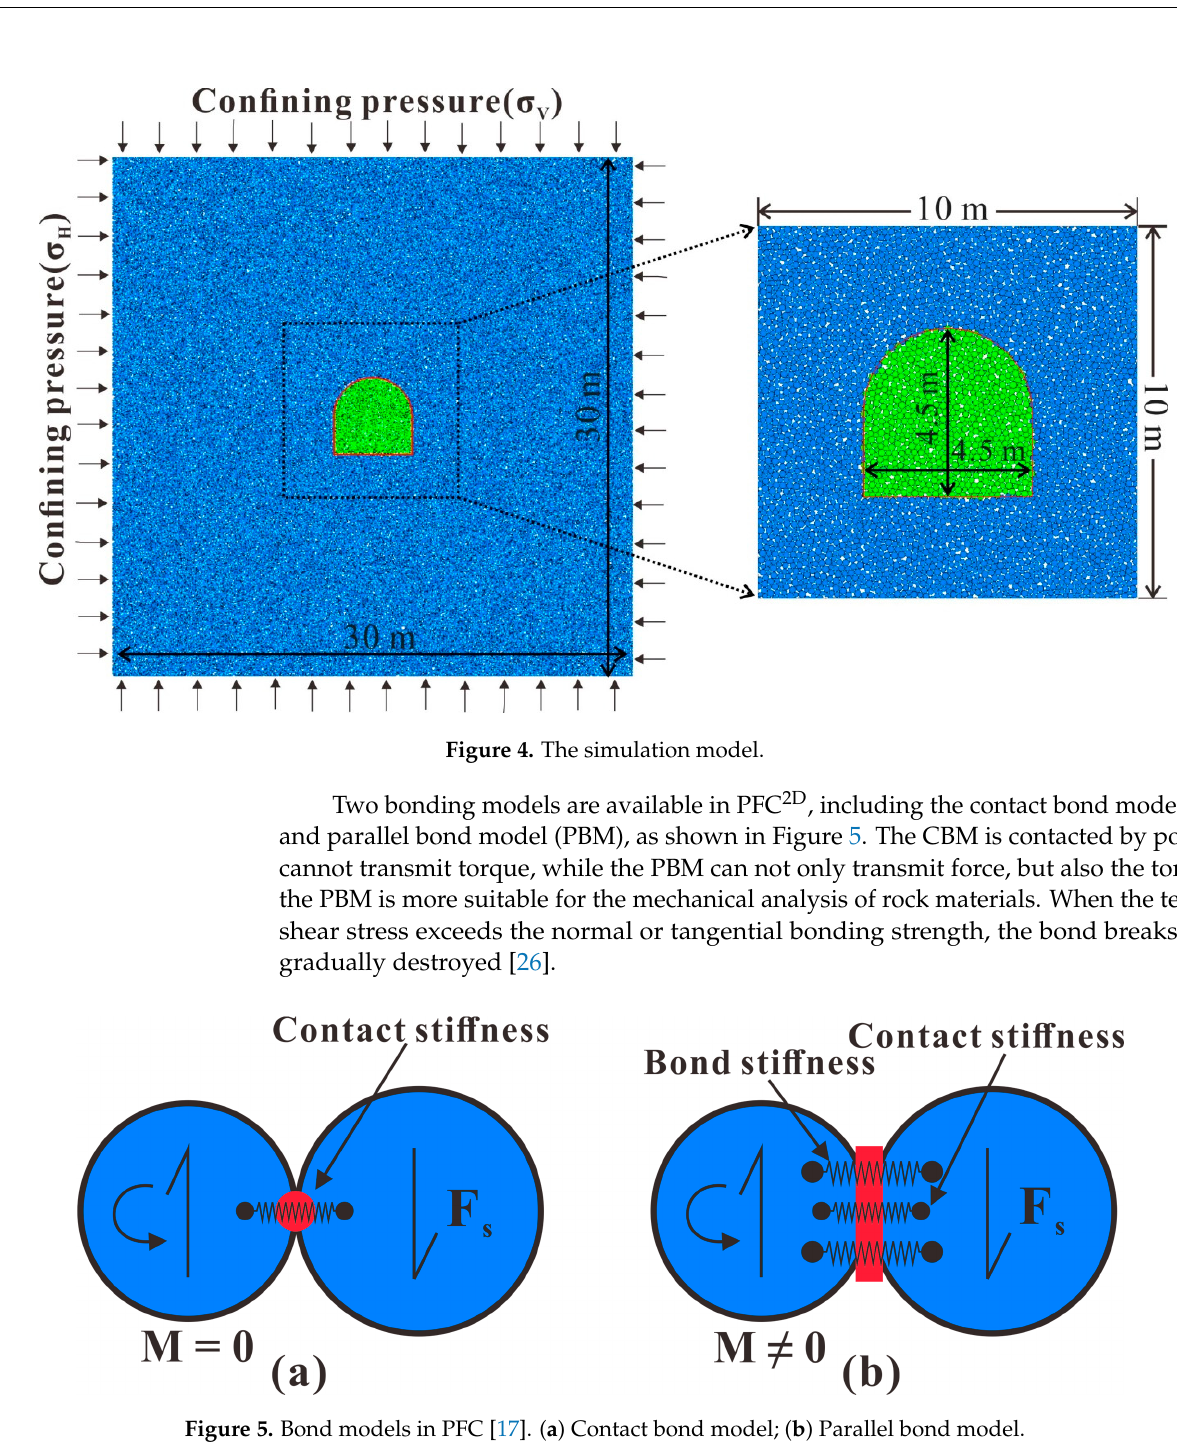
Figure 6. Rock mass model of different models. ( a ) Layered rock mass; ( b ) rhomboid rock mass. DFN (Discrete fracture network).